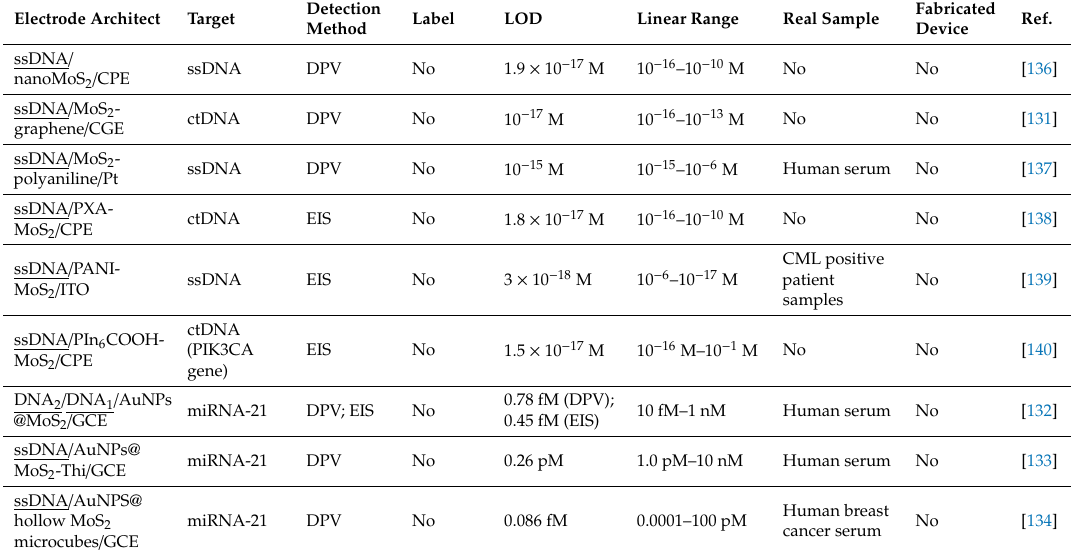
Table 4. Reported studies of molybdenum disulfide (MoS 2 )-based electrochemical biosensors for nucleic acid cancer biomarker detection. The underlined terms are the